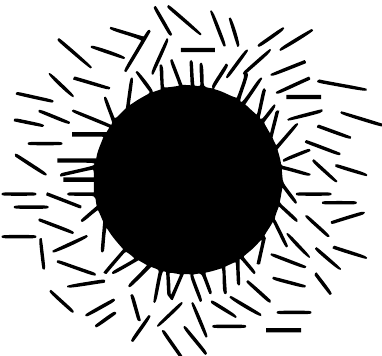
Figure 1. Representation of the distribution of rods around a sphere; here, we show a cross section of the three-dimensional system. For large particle concentrations, the rods are forced to align around the sphere; this alignment decreases towards the